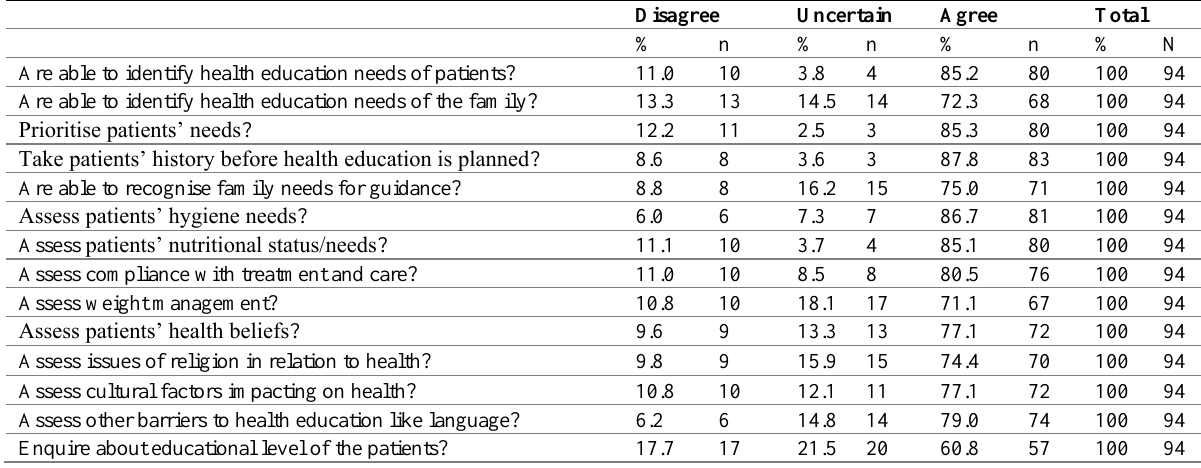
Table 1: Assessment preceding health education